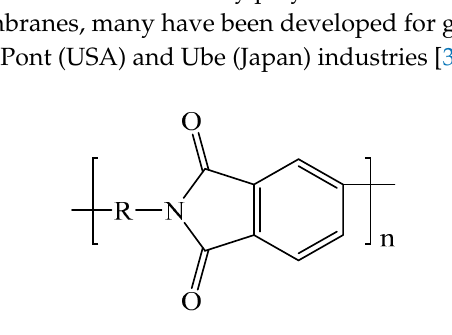
Figure 2. Chemical structure of polyimides.